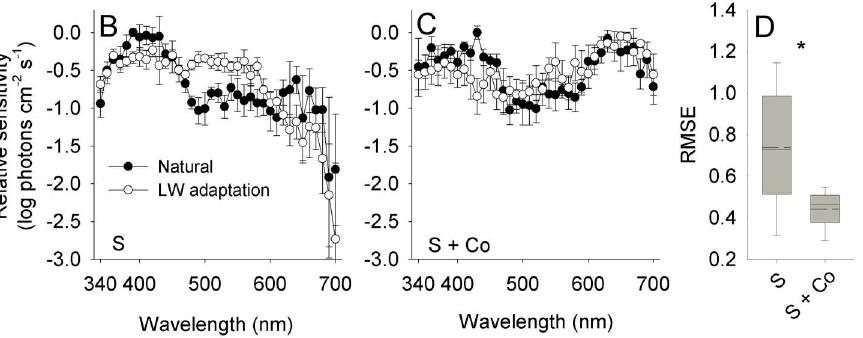
Figure 5. HC-cone feedback increases the efficiency of color induction at the optic nerve. (A,B) Spectral sensitivity of the optic nerve measured from saline-treated retina (S) and retina treated with saline and cobalt (S + Co). Application of cobalt induced a change in the shape of spectral sensitivity, increasing the sensitivity to long wavelengths (observed for sensitivity measured under both backgrounds). Error bars, 6 1 SEM. Sample size: S: Natural=5, LW adaptation=5; S + Co: Natural=5, LW adaptation=5. (C) The efficiency of color induction, as indicated by the RMSE between the spectral sensitivity under the two backgrounds, decreased significantly with the application of cobalt (marked with an asterisk; see text for statistics). Box specifications as in Figure 3.